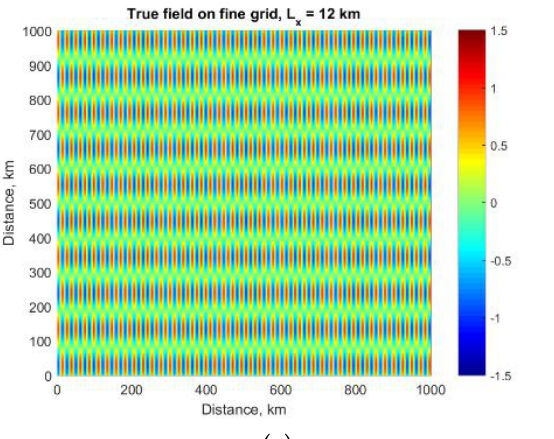
Figure 8. Spatial distribution of the diagonal elements 𝑉 𝐵,𝑖𝑖 ( a ) and 𝑉 𝑅,𝑖𝑖 ( b ) in the example of a single eddy of a radius of 16 km.